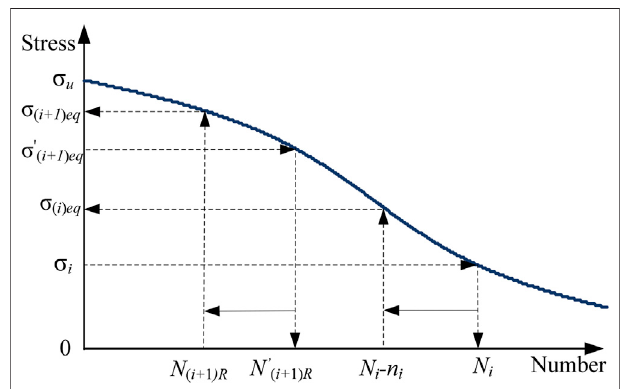
FIGURE 1 | Schematic representation of parameters in the whole-range S-N